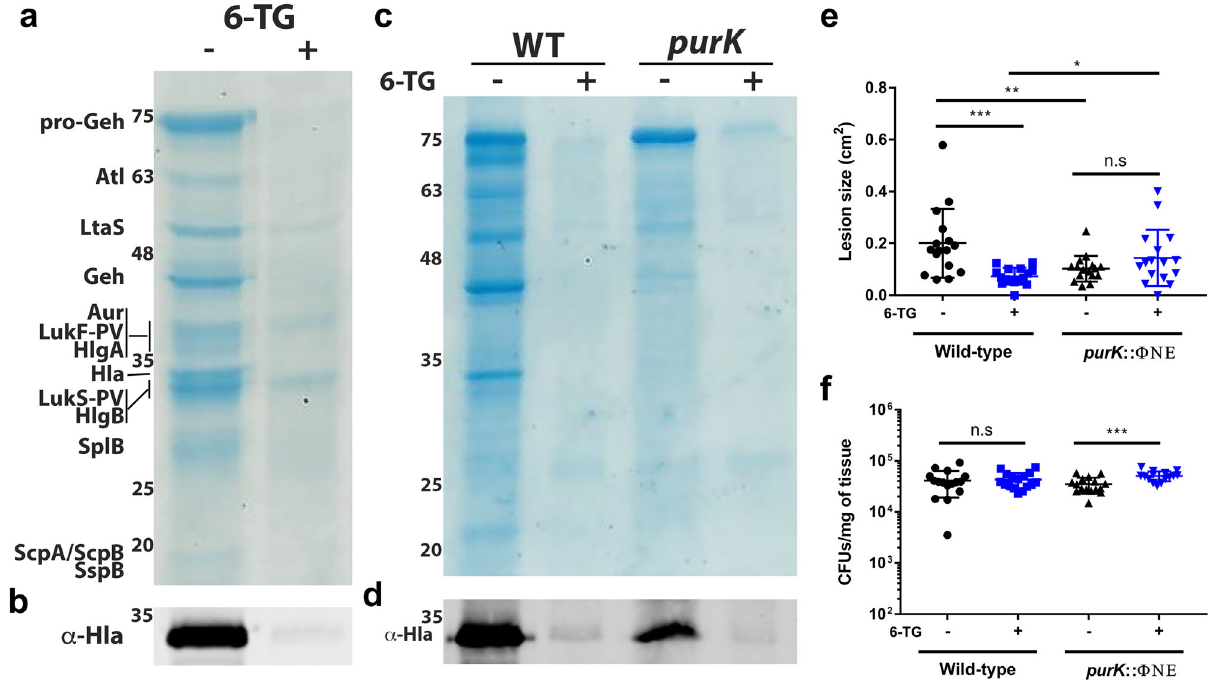
signi fi cant differences in the number of transcripts were found wild-type cells when both cultures were treated with